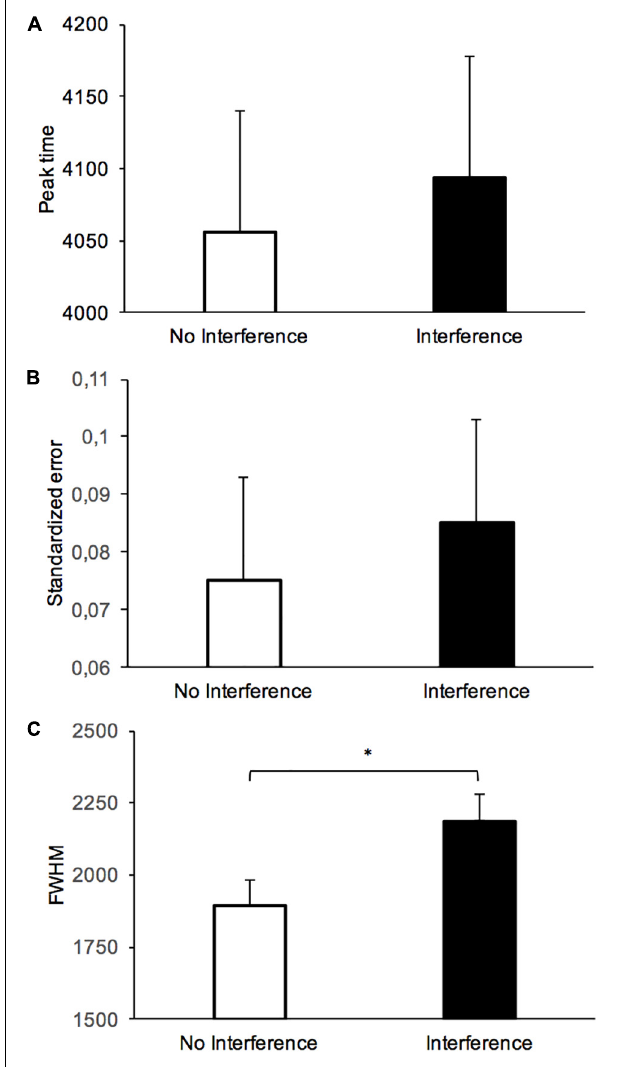
FIGURE 3 | Mean ( + SD ) peak time (ms) (A) , standardized error (B) , and FWHM (C) in the long-term memory test with or without an interference task during the long-term memory consolidation